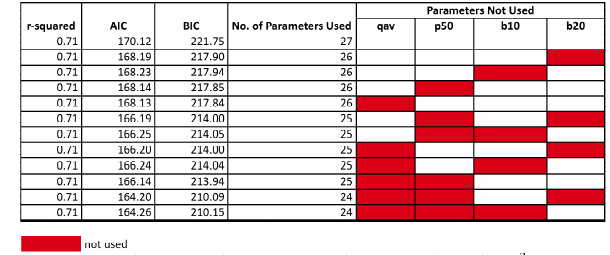
Figure 5: First Run Result Threshold value r 2 >0.71 The Q. Average, 50 th percentile, 10 th bincentile and 20